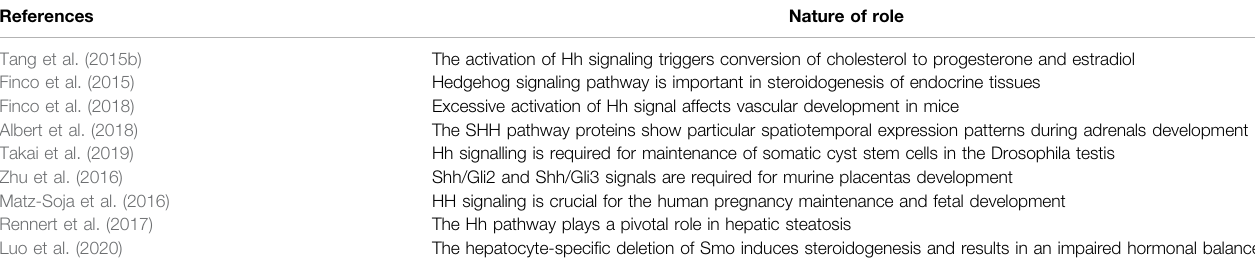
TABLE 3 | Summary of role for HH in steroid-associated organs and steroid